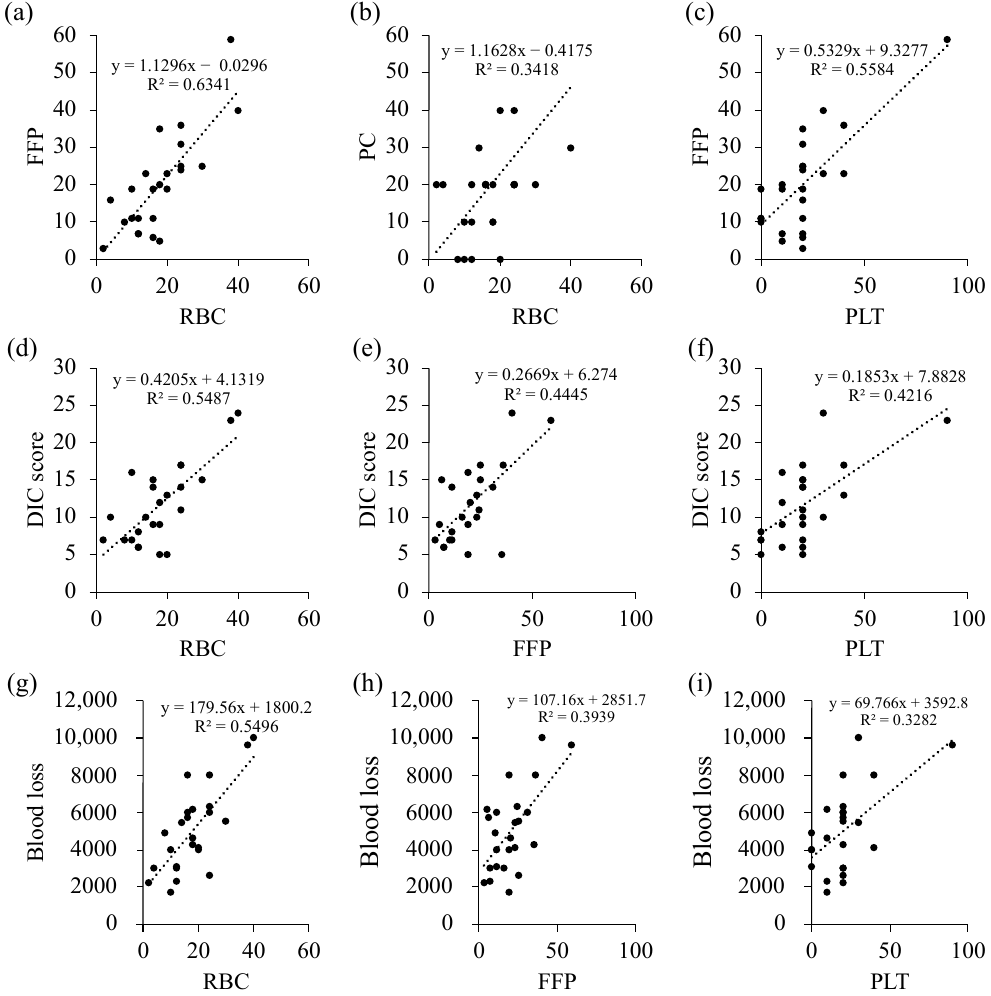
Figure 2. Correlation of the amount of RBC, FFP, and PLT transfusion; obstetrical DIC score; and blood loss. Correlation of RBC and FFP ( a ); RBC and PLT ( b ); FFP and PLT ( c ); DIC score and RBC ( d ), FFP ( e ), and PLT ( f ); blood loss and RBC ( g ); FFP ( h ); and PLT ( i ). DIC, disseminated intravascular coagulation; RBC, red blood cells; FFP, fresh frozen plasma; PLT, platelet. The amount of RBC, FFP, and PLT transfusions is described by Japanese units, which is defined as that derived from 200 mL whole blood. Table 5. Correlation coefficient of RBC, FFP, PLT, obstetrical DIC score, and blood loss.